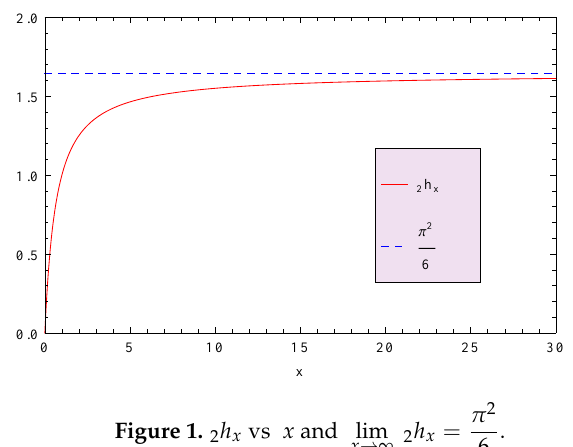
Figure 1. 2 h x vs x and lim